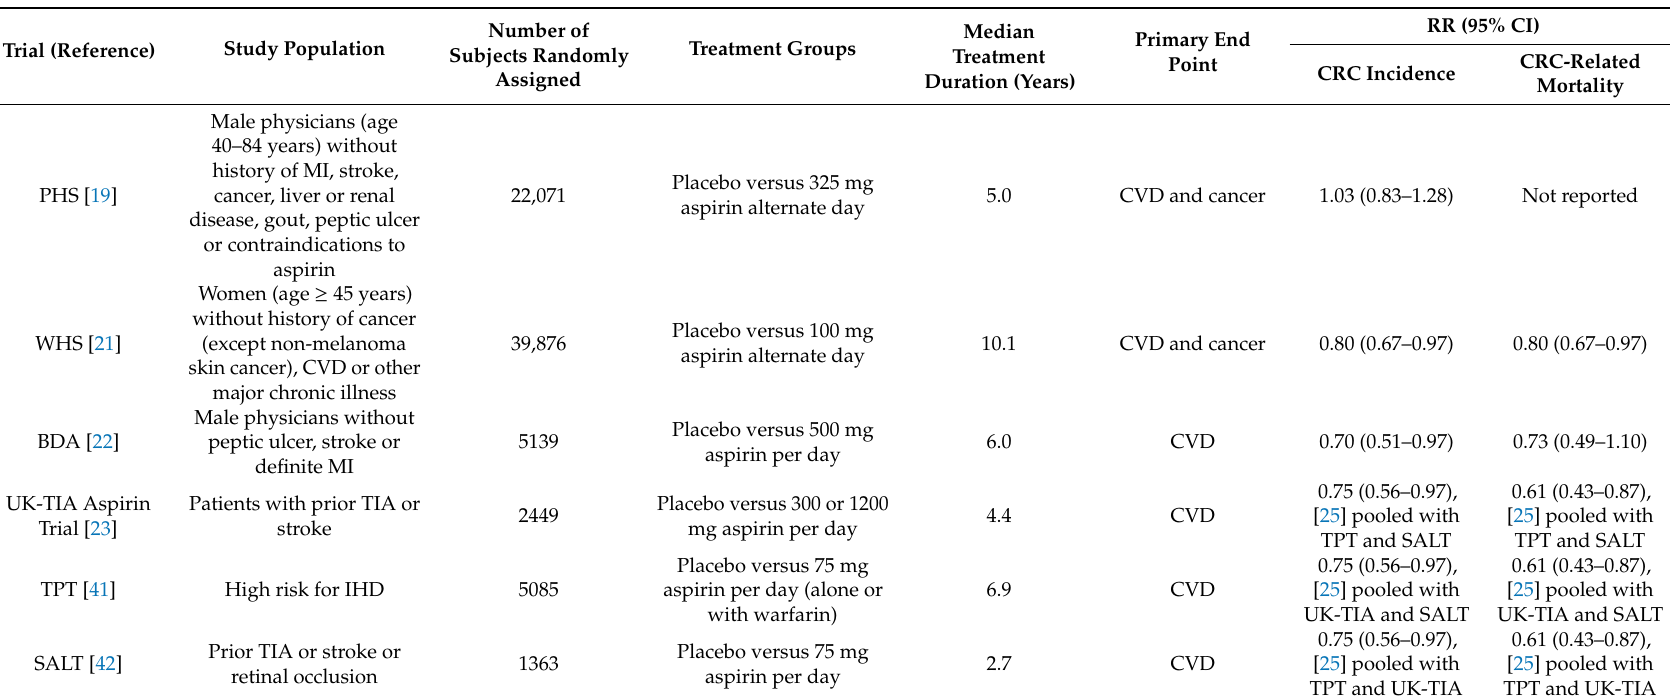
Table 1. Placebo-controlled trials of aspirin for the prevention of cardiovascular disease (CVD) ± cancer reporting colorectal cancer (CRC) incidence and CRC-related